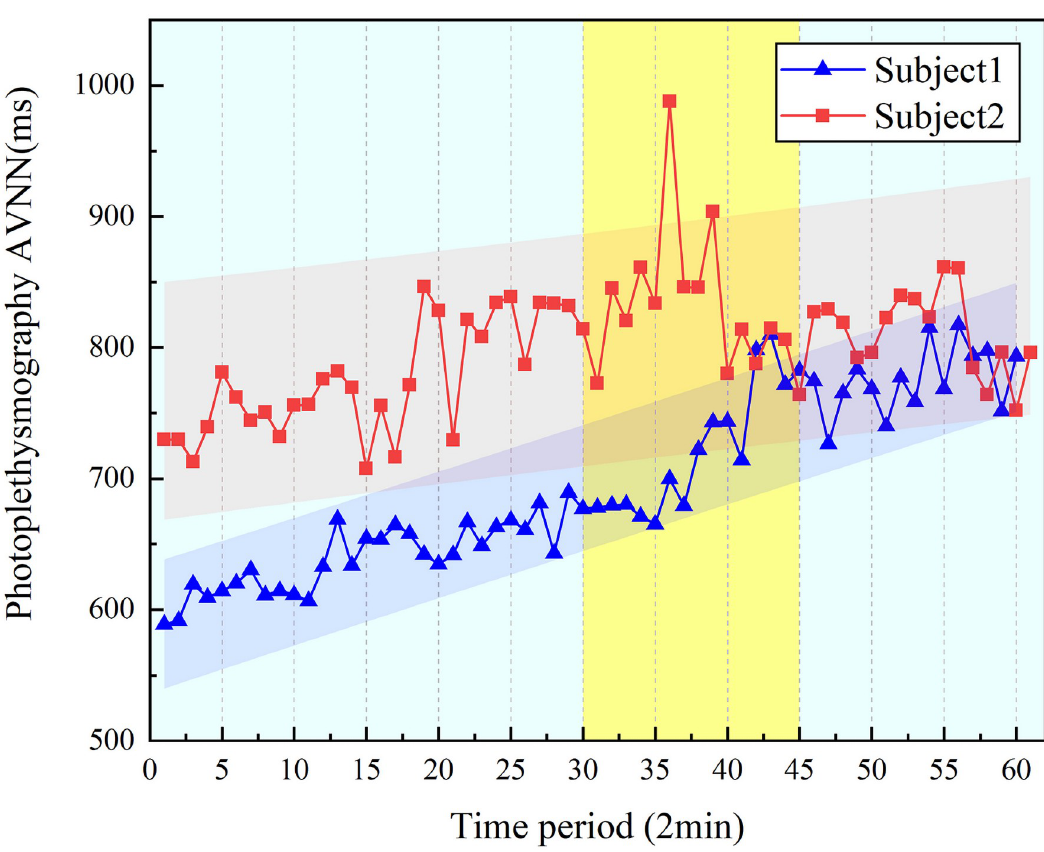
Fig 15. Comparison of PPG signal before and after